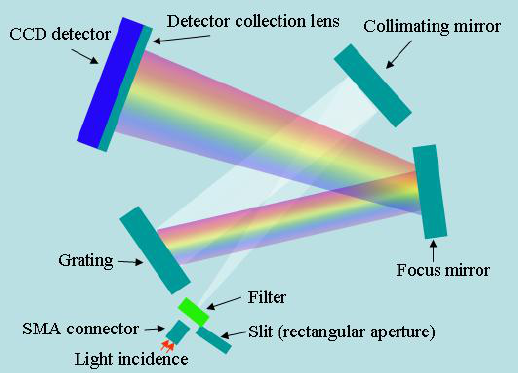
Figure 4. OES module configuration.